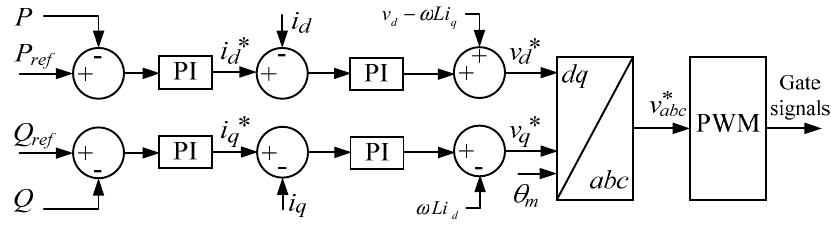
Figure 8. Grid feeding inverter controller.